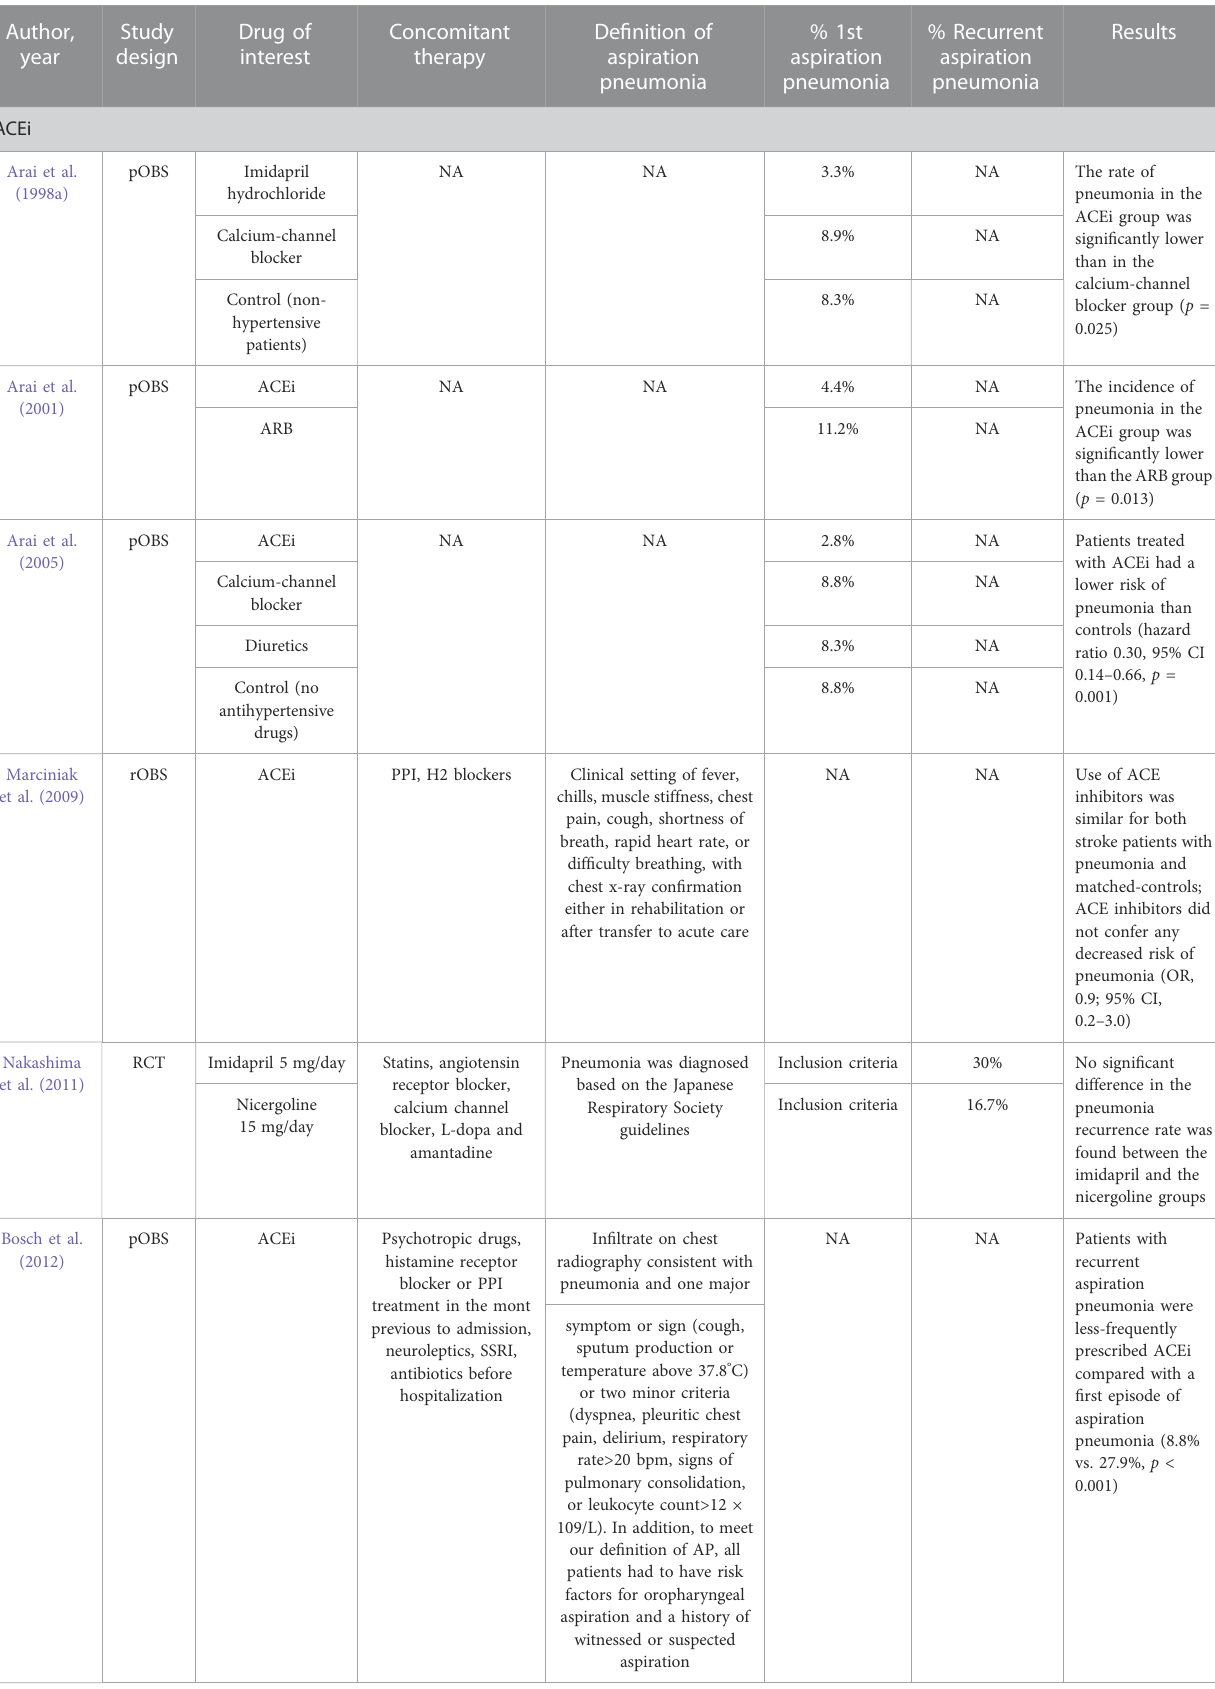
TABLE 3 Effects of pharmacological treatments on fi rst or recurrent aspiration pneumonia